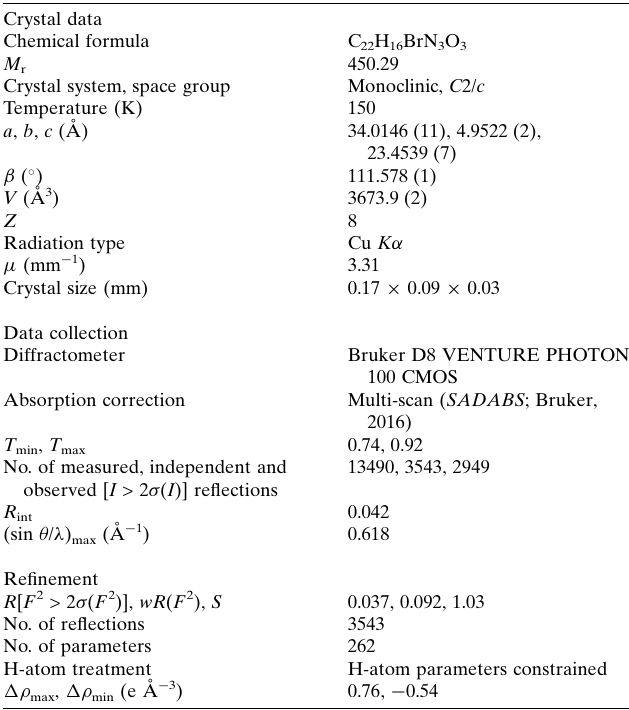
Table 2 Experimental